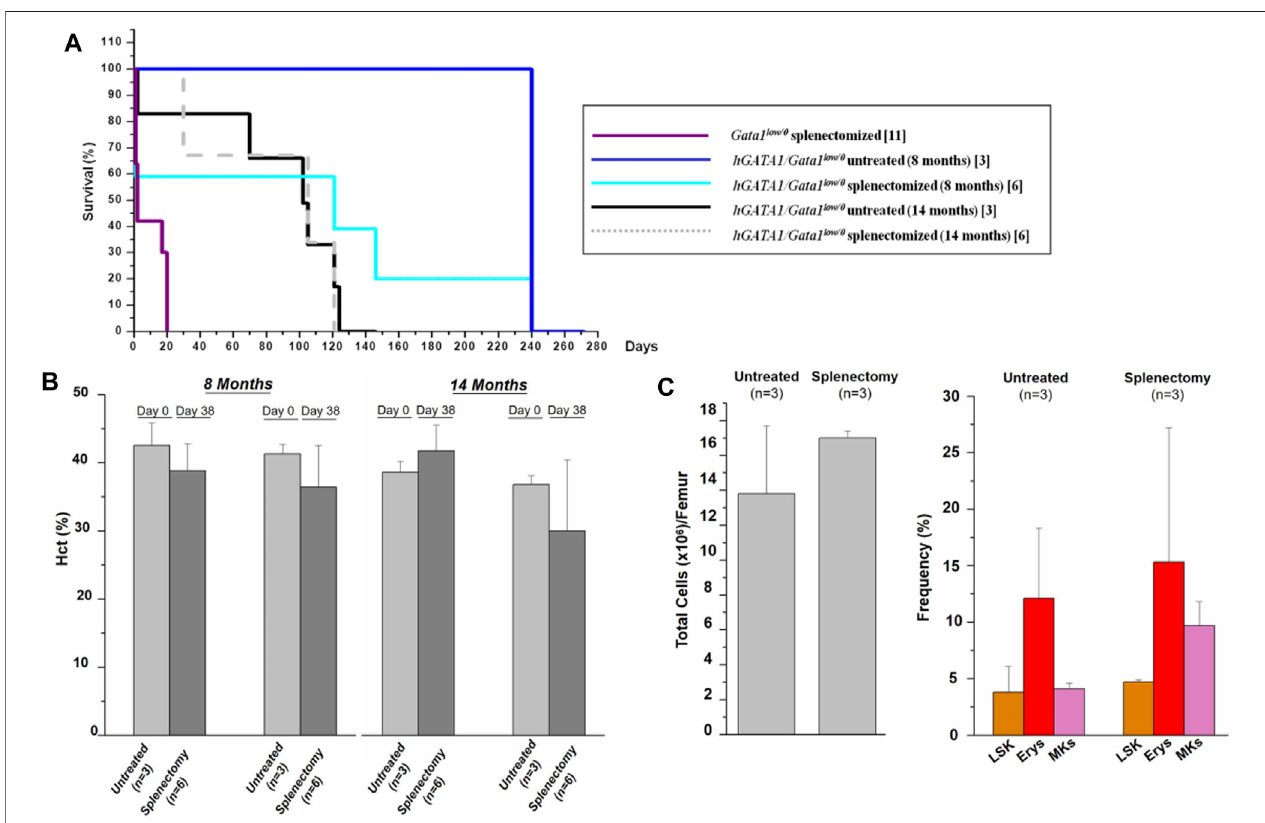
FIGURE 7 | The presence of hGATA1 rescues erythropoiesis in the bone marrow of Gata1 low/0 mice. Survival (A) and hematocrit (B) of untreated hGATA1/ Gata1 low/0 mice and of their littermates subjected to splenectomy. At the time of splenectomy, mice were either 8- or 14-month old, as indicated. In comparison to Gata1 low/0 mice, hGATA1/Gata1 low/0 survivewellsplenectomy,demonstratingthatthebonemarrowinthesemiceisafunctionalerythroidorgan.Furthermore,atday38, untreated and splenectomized mice have similar Hct values and these values are not different from those observed at day 0, demonstrating that the spleen has a marginal role in the erythropoiesis of Gata1 low/0 mice carrying the hGATA1 transgene. (C) Total cell number (left panel) and frequency of LSK (Lin − /CD117 pos /Sca1 pos ), and erythroid (TER119 pos /CD71 pos ) and megakaryocyte (CD41 pos /CD61 pos ) precursors (right panel) from untreated hGATA1/Gata1 low/0 mice and from their littermates subjectedtosplenectomy.Themiceweresplenectomizedat8-monthsofageandanalyzed240daysafterthesurgery.( n )indicatesthenumberofmiceincludedineach experimentalgroup.StatisticalanalyseswasperformedbyOne-wayanalysisofvariance Dunnett ’ sMultipleComparison Test.Resultsofthestatisticalanalyses:in (B,C) there are no statistically signi fi cant differences among